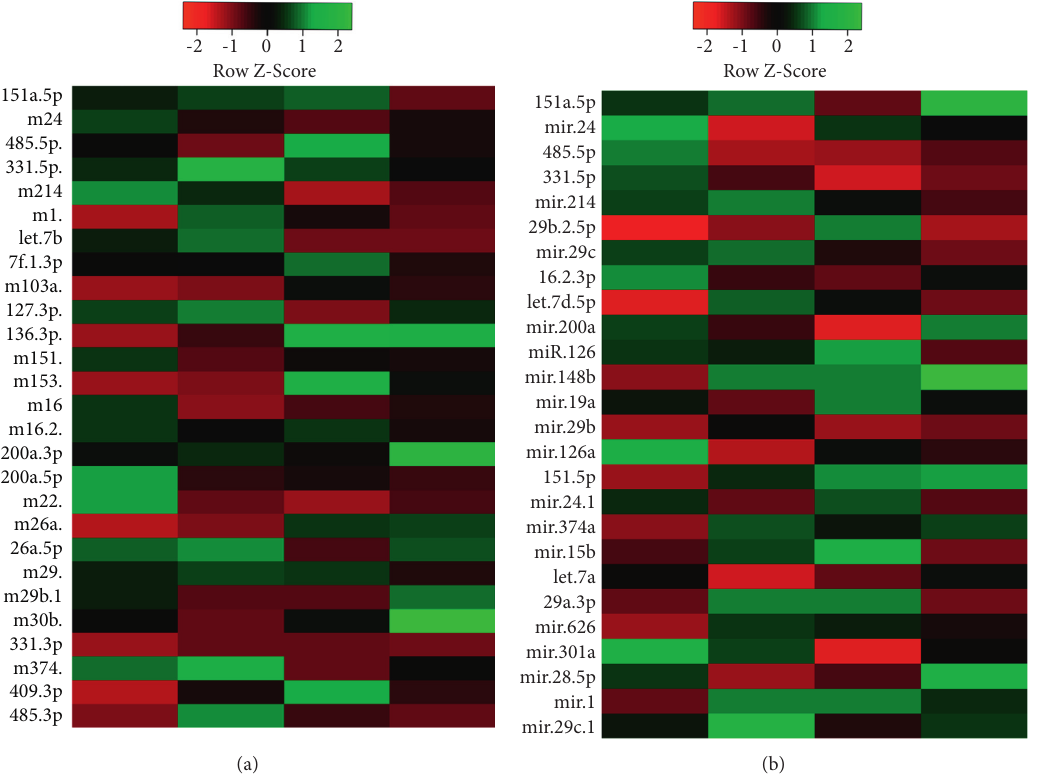
Figure 2: Heat map plot of (a) serum and (b) cerebrospinal fluid (CSF) microRNA